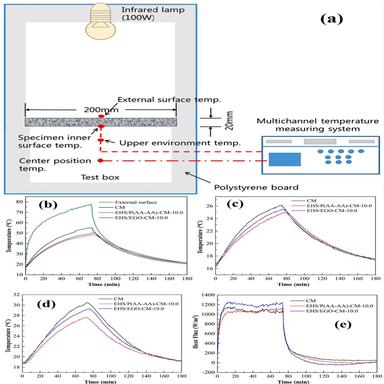
(a) Schematic of heating setup, thermal performance comparison between CM and EHS/EGO-CM-10.0 and EHS/P(AA-AA)-CM-10.0: (b) sample external and inner surface temperature, (c) the center position temperature of test box, (d) the upper environment temperature of test box, and (e) the heat flux change on the inside and outside surface of specimens. Reproduced with the permission of Elsevier.